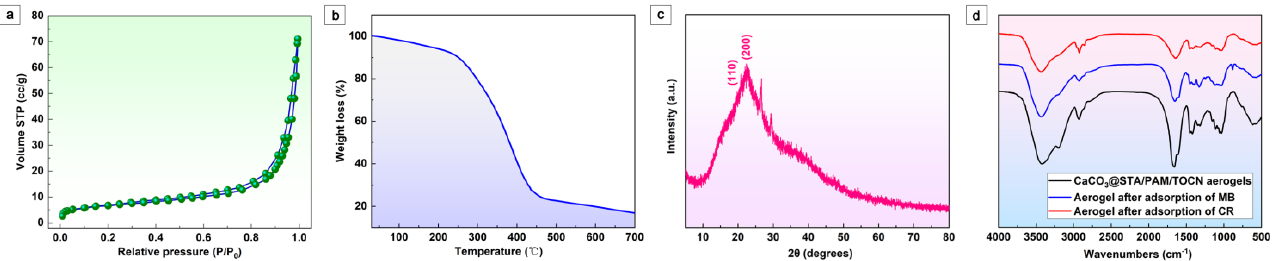
Figure 2. ( a ) Nitrogen adsorption–desorption isotherms of CaCO 3 @STA/PAM/TOCN aerogels; ( b ) TGA results of CaCO 3 @STA/PAM/TOCN aerogels; ( c ) XRD patterns of CaCO 3 @STA/PAM/TOCN aerogels; ( d ) FITR of CaCO 3 @STA/PAM/TOCN aerogels.